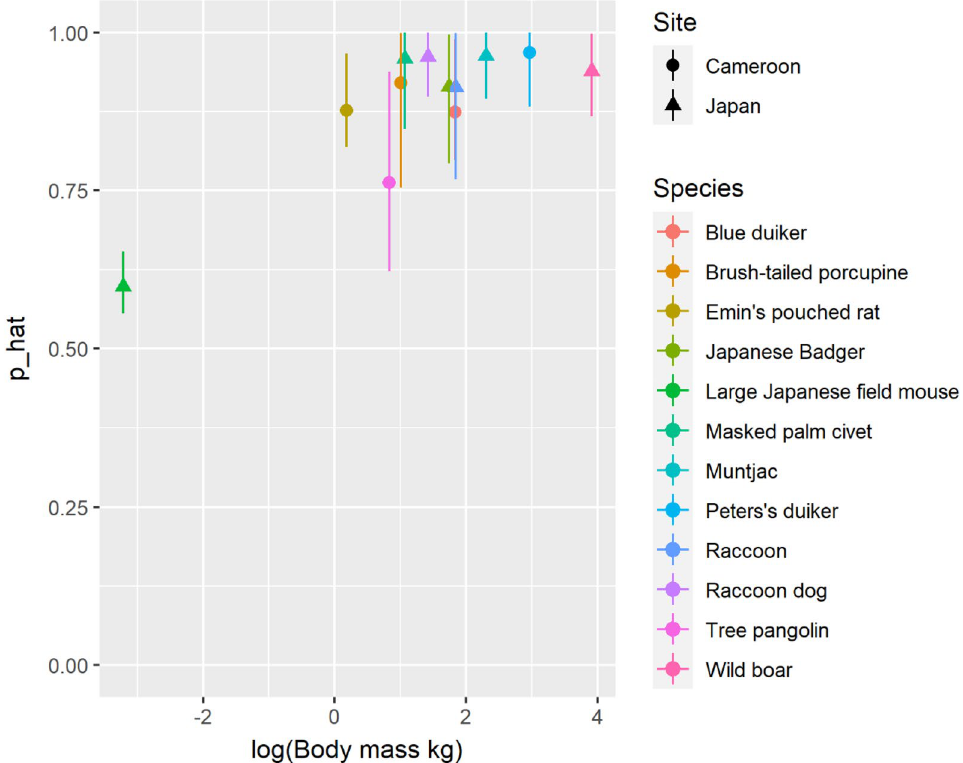
Figure 2. The estimated detection probability of 12 species within a small focal area (1.56 m 2 ) in Cameroon (5 species) and Japan (7 species) using the capture-recapture models for stratified populations. Error bar shows the 95% credible